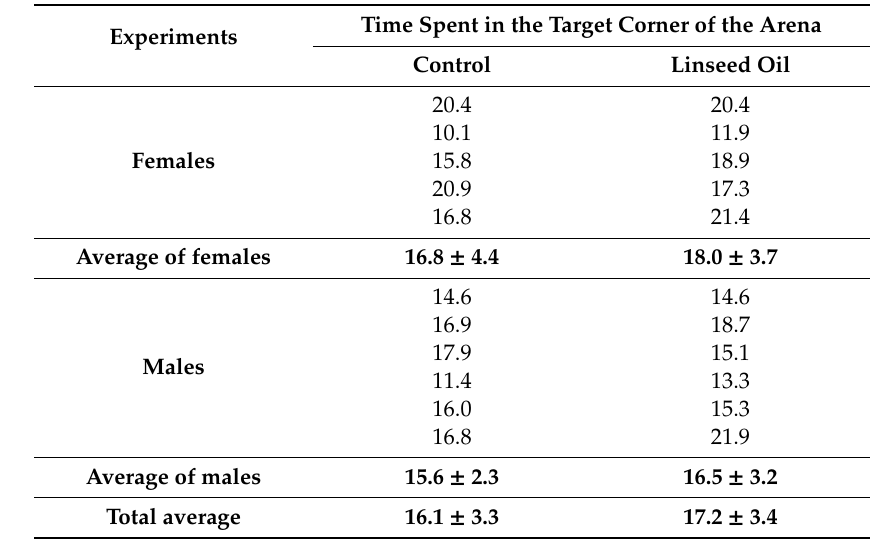
Table 2. Time any individual spent in the target corner of the arena before and after the addition of the linseed oil. Males and females were tested in separate experiments. Total observation time = 25 min, Group size = 5 individuals, N = 11.